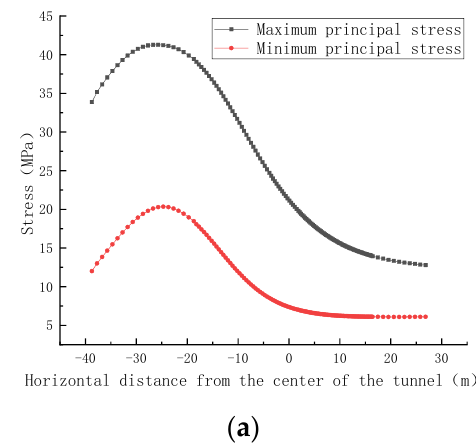
Figure 25. Changes in the principal stresses of the roadway’s surrounding rock when the coal column is 25 m. ( a ) Horizontal direction. ( b ) Variation direction. According to the plastic zone distribution cloud map (Figure 26), the maximum damage depth of the plastic zone of the roadway is 7.5 m, the plastic zone appears with an obvious butterfly shape, and the upper butterfly lobe’s development is obvious and is mainly distributed at the top of the roadway and the positive gang. The lower butterfly lobe’s development is smaller. The upper butterfly lobe points to the direction of the residual coal pillar. The plastic zone of the roadway’s surrounding rock and the plastic zone at the residual coal pillar are not yet connected.